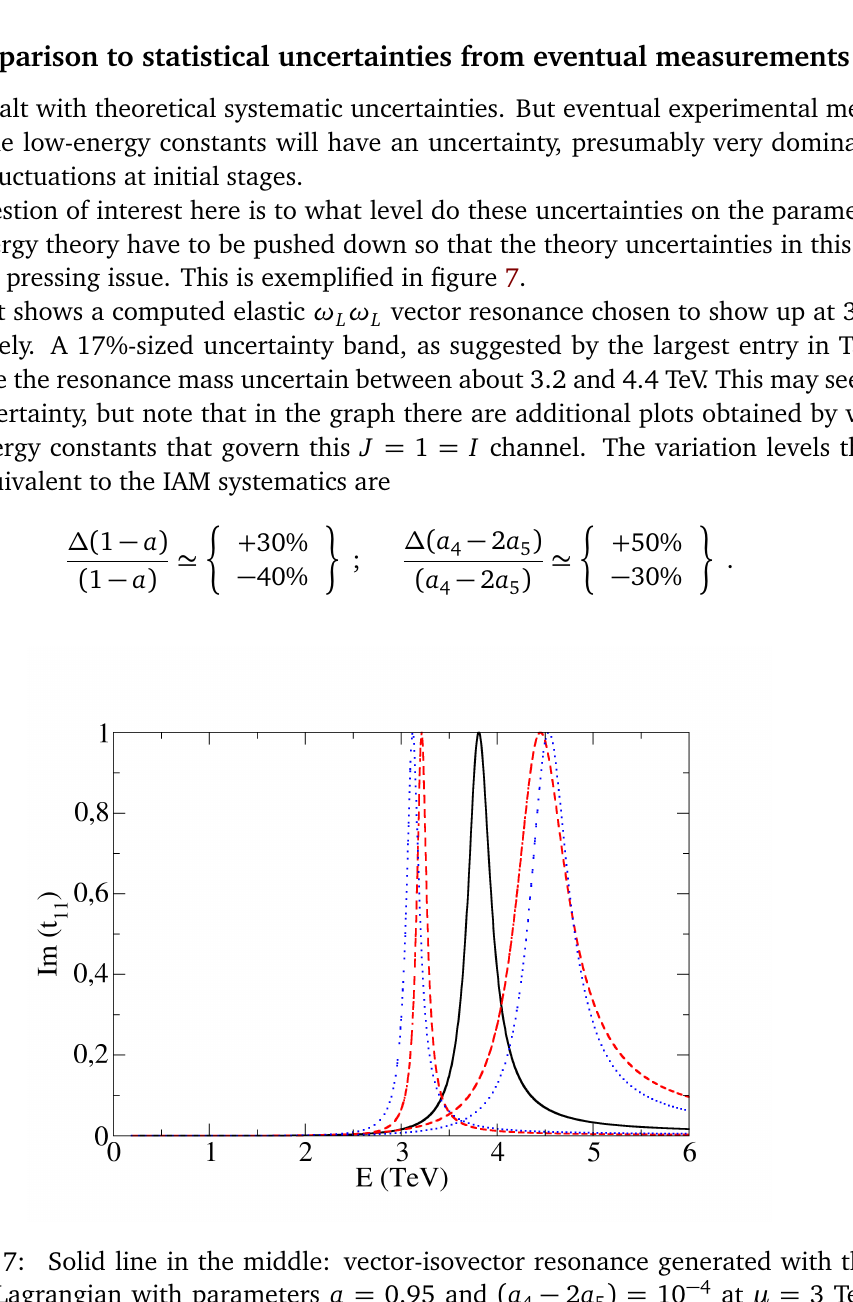
− 2 a ) = 10 − 4 at µ = 3 TeV. 4 5 − 2 a increased by 50% or 4 5 − 2 a = 0, the further to the 4 5